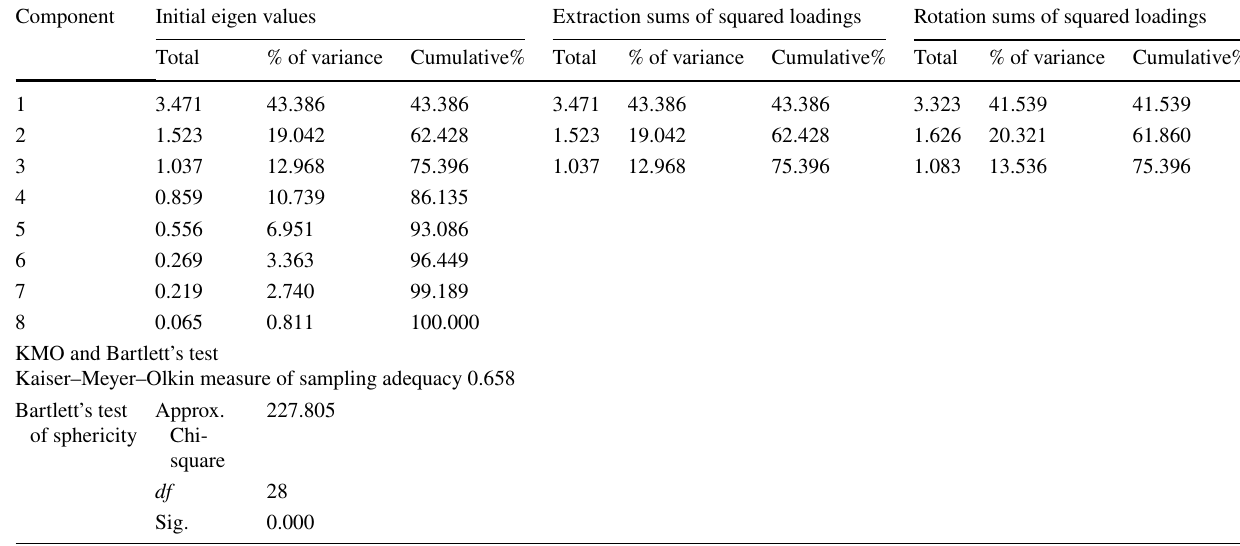
Table 9 Results of the principal component analysis for the groundwater samples during pre-monsoon season, total variance explained